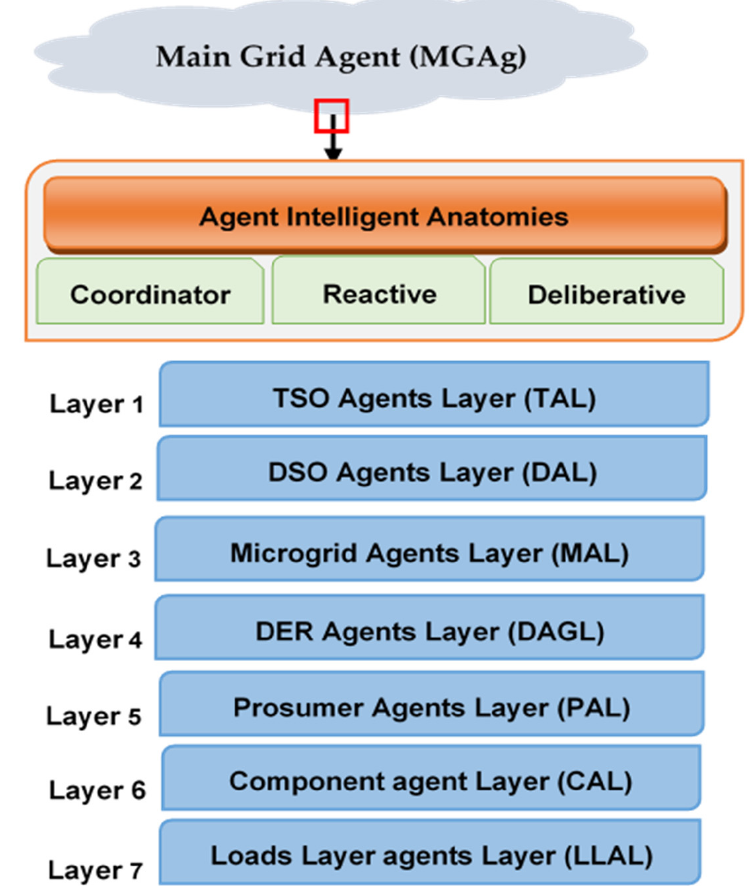
Figure 6. SG agents-based control architecture.